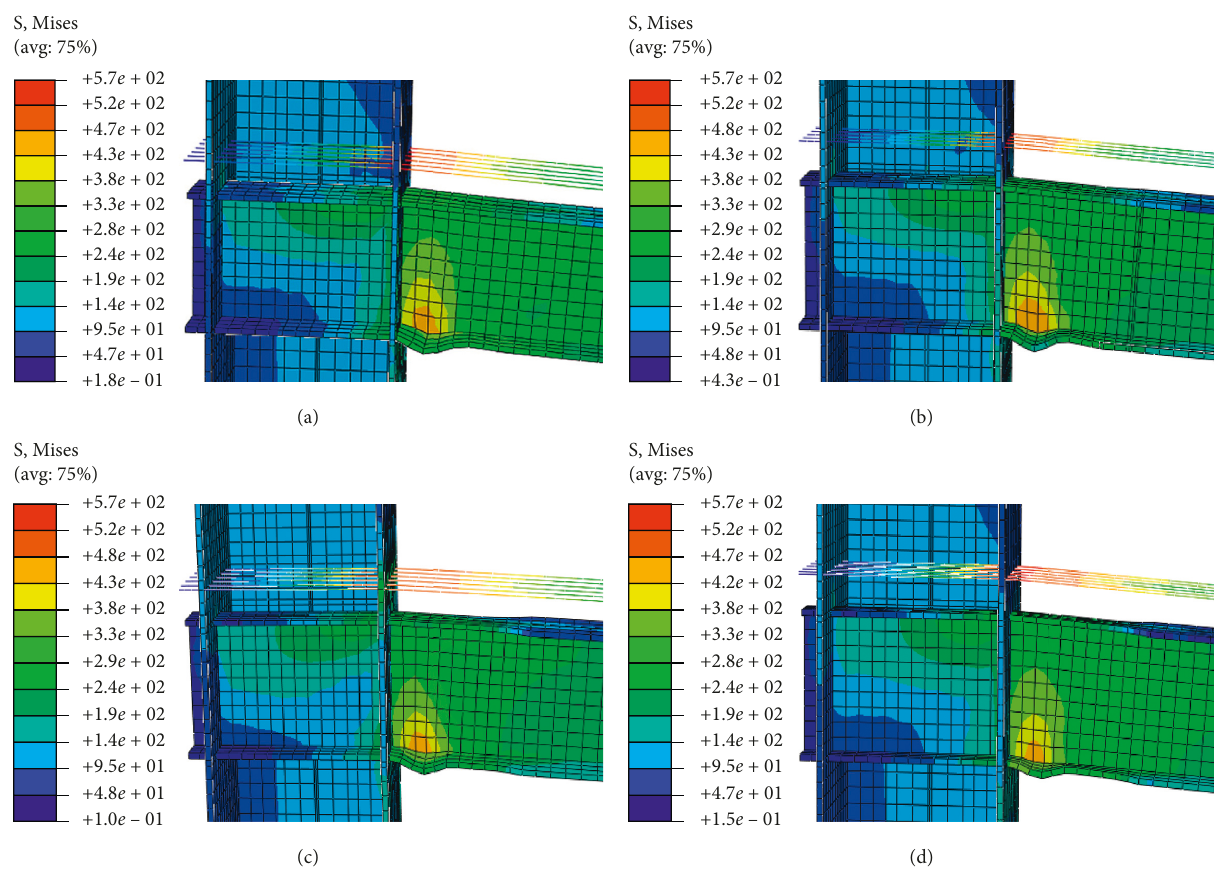
Figure 10: Stress cloud diagram for TC reinforcements and steel girder (MPa): (a) CFCJ1; (b) CFCJ2; (c) CFCJ3; (d)